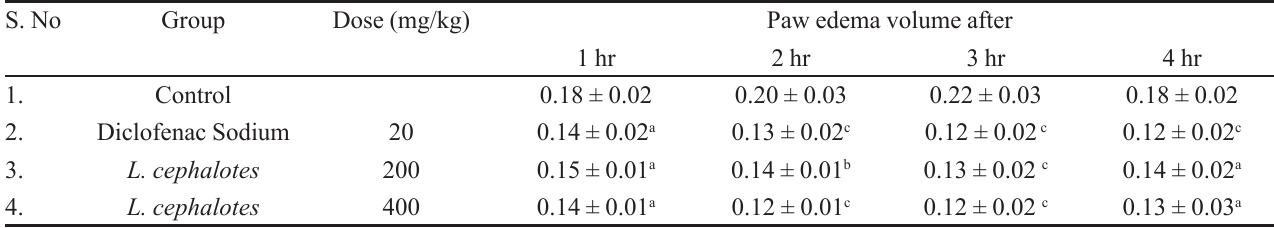
Values are expressed as mean ± SD; (n =6), a= p < 0.05, b= p < 0.005, c= P< 0.0005 Vs Control. TABLE II - Effect of methanolic extract from L. cephalotes on the paw edema test in rats S.